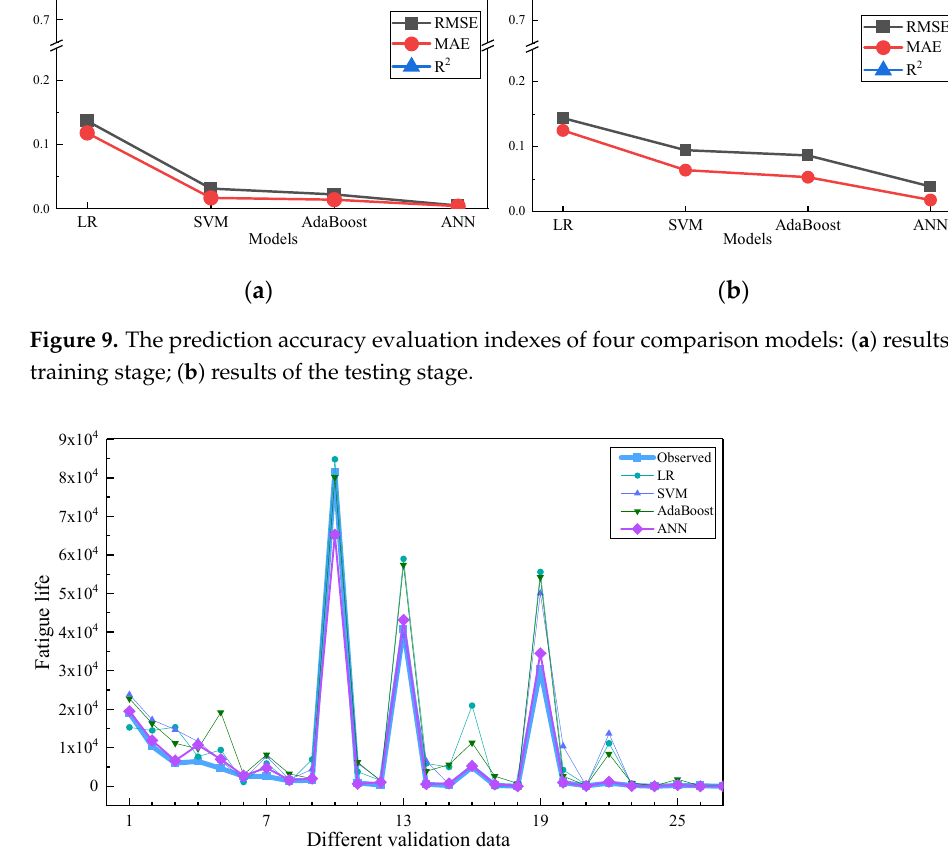
Figure 10. Predicted value of the four comparative models.